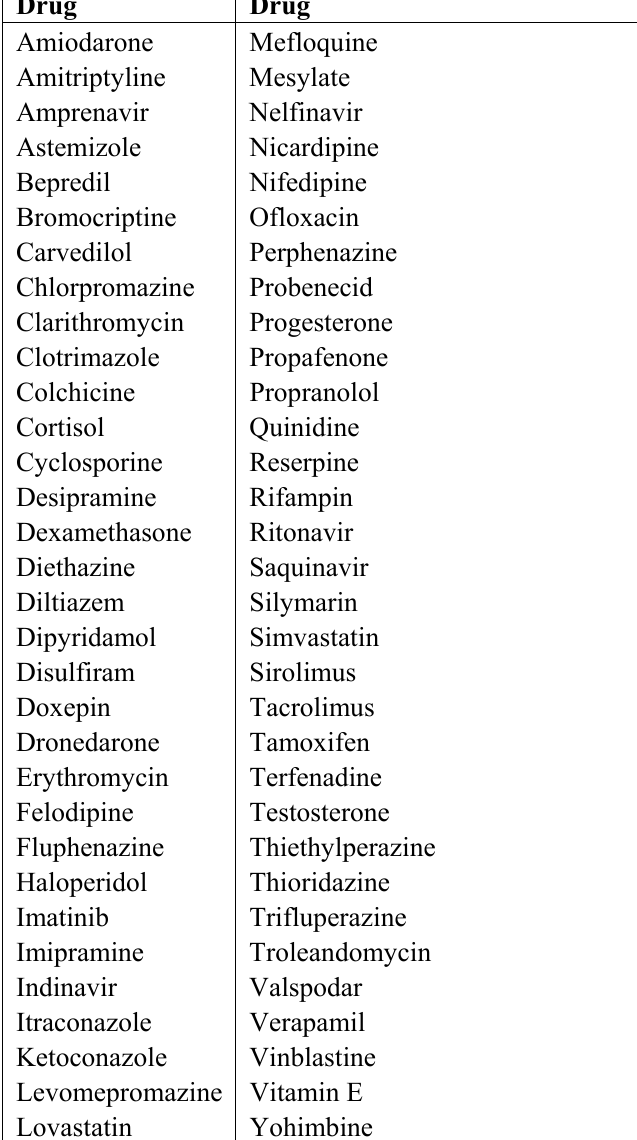
Table 3. Drugs, food components and herbs known to affect P-glycoprotein activity [44,45]. Drug Drug